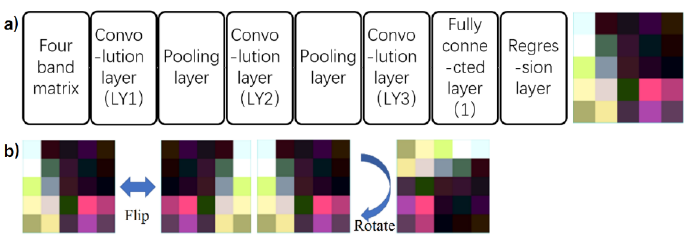
Figure 3. Structure diagram of CNN ( a ) and Matrix expansion method ( b ) [53].